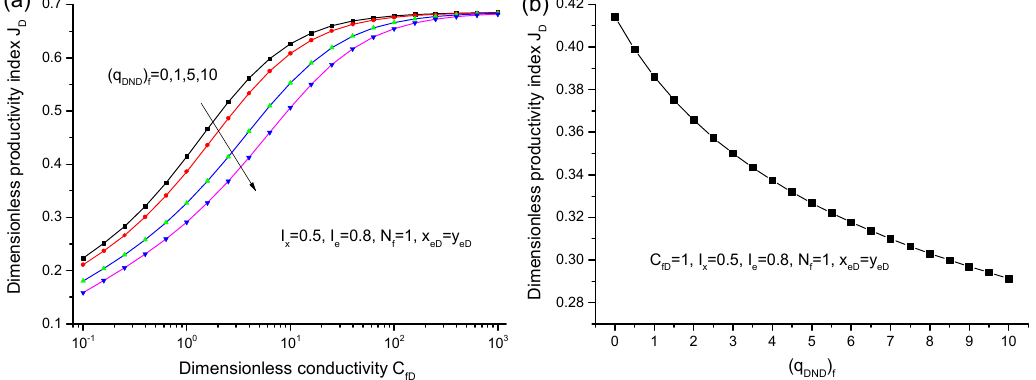
Figure 12. ( a ) Influence of fracture conductivity on PI behavior under the effect of non-Darcy flow, ( b ) influence of Forchheimer number on PI behavior with the consideration of finite conductivity.